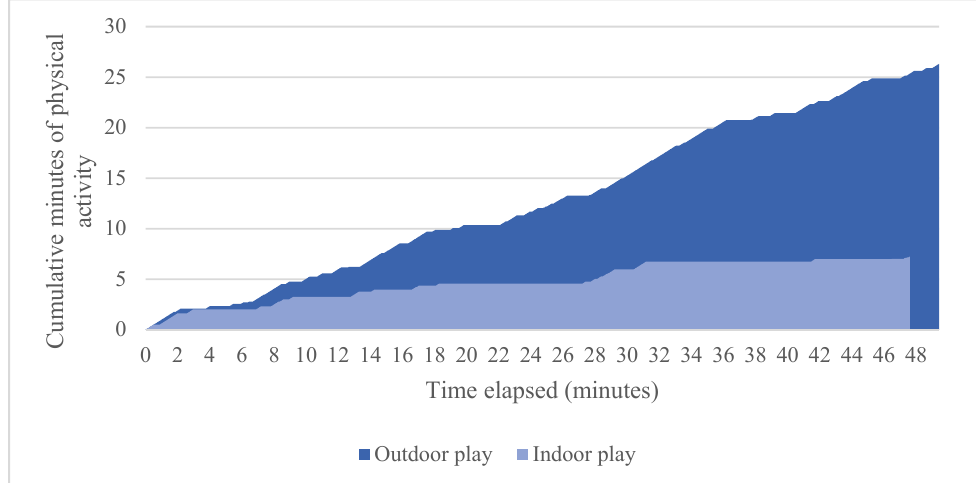
Figure 3. Cumulative minutes of physical activity during indoor activities for a 4-year-old male participant.